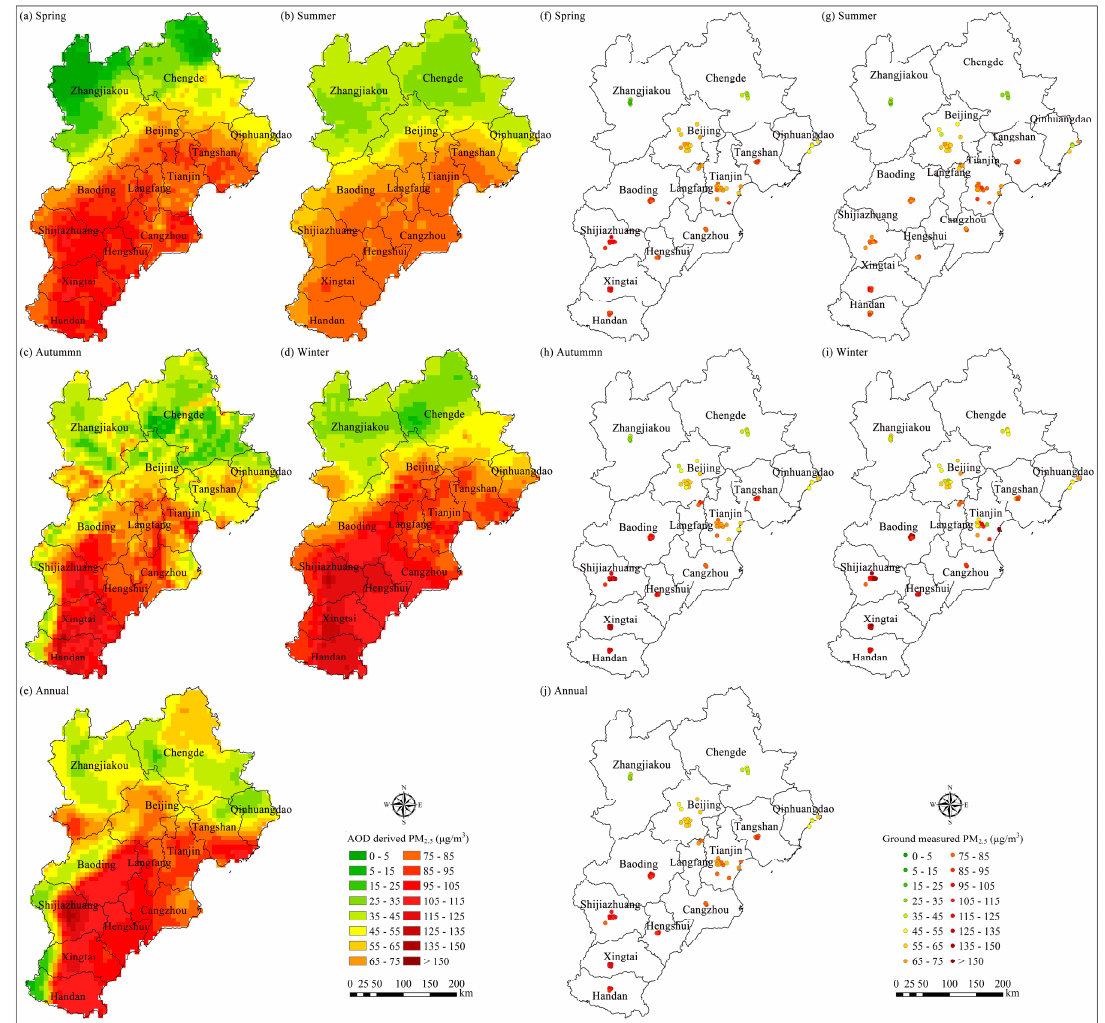
Figure 4. Comparisons of seasonal and annual mean AOD-derived PM 2.5 and ground-measured PM 2.5 concentrations. ( a – e ) are AOD-derived PM 2.5 concentrations of spring, summer, autumn, winter, and annual, respectively; ( f – j ) are ground-measured PM 2.5 concentrations of spring, summer, autumn, winter, and annual, respectively.